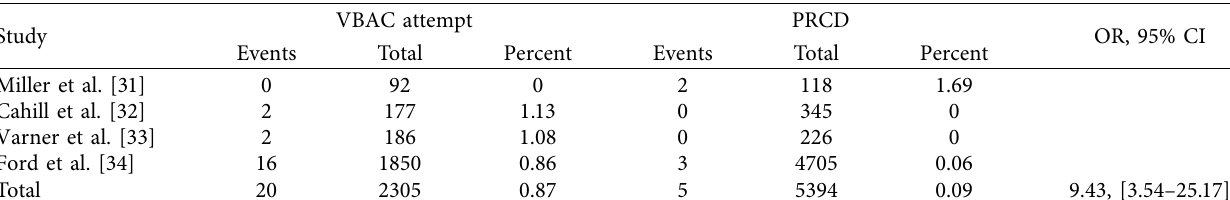
Table 2: Study outcomes